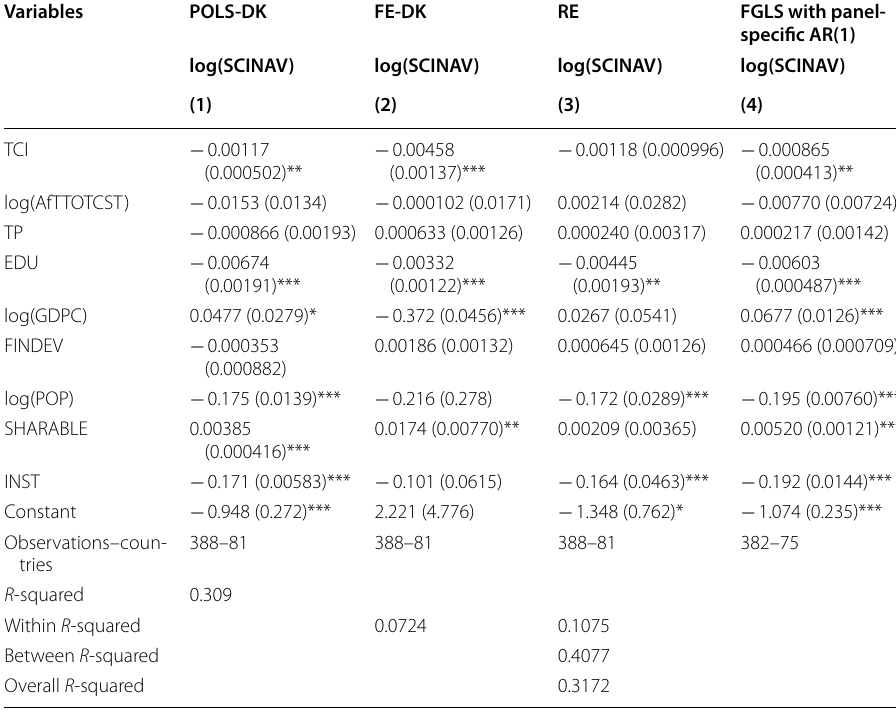
Table 1 Effect of AfT flows and development strategy on structural change in